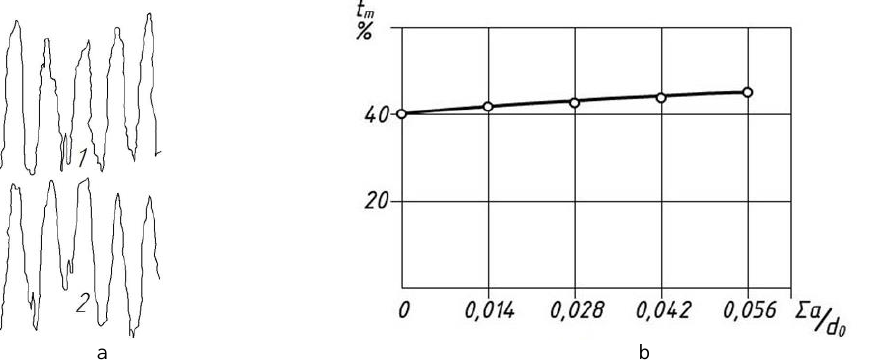
Fig. 2. The profile of the initial and processed surface (a) and the reference length of the profile at the midline level (b): 1 – the initial surface after boring, 2 – the surface after 4 cycles of